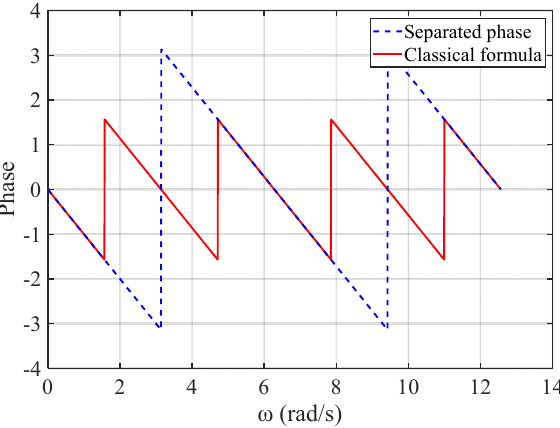
Figure 2. Phases obtained by two schemes.